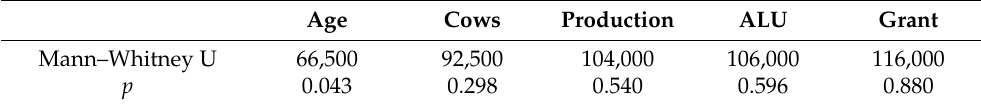
Table 4. Mann–Whitney U